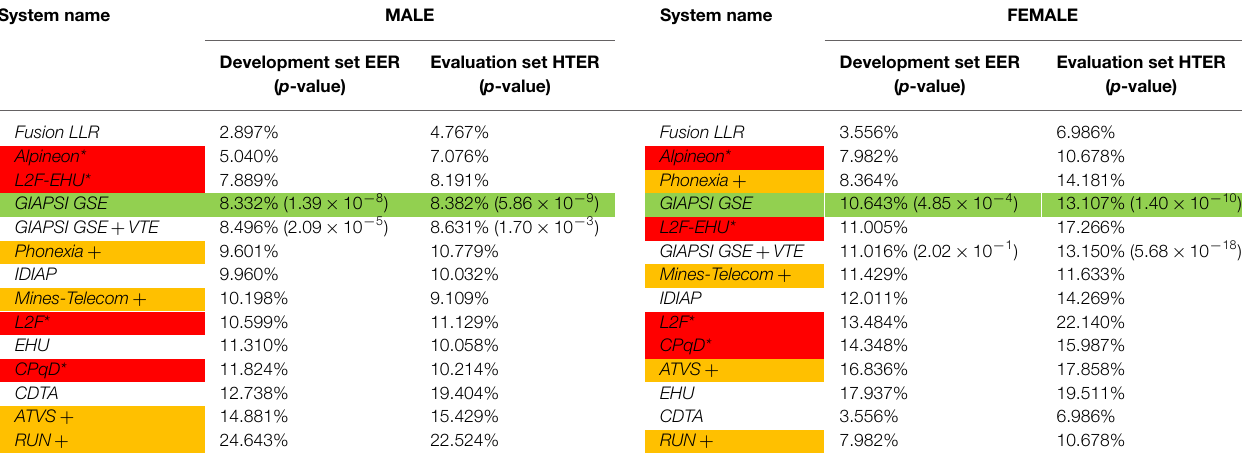
TABLE 7 | EER on the development set and HTER on the evaluation set for the systems participating in 2013 SRE in Mobile Environments